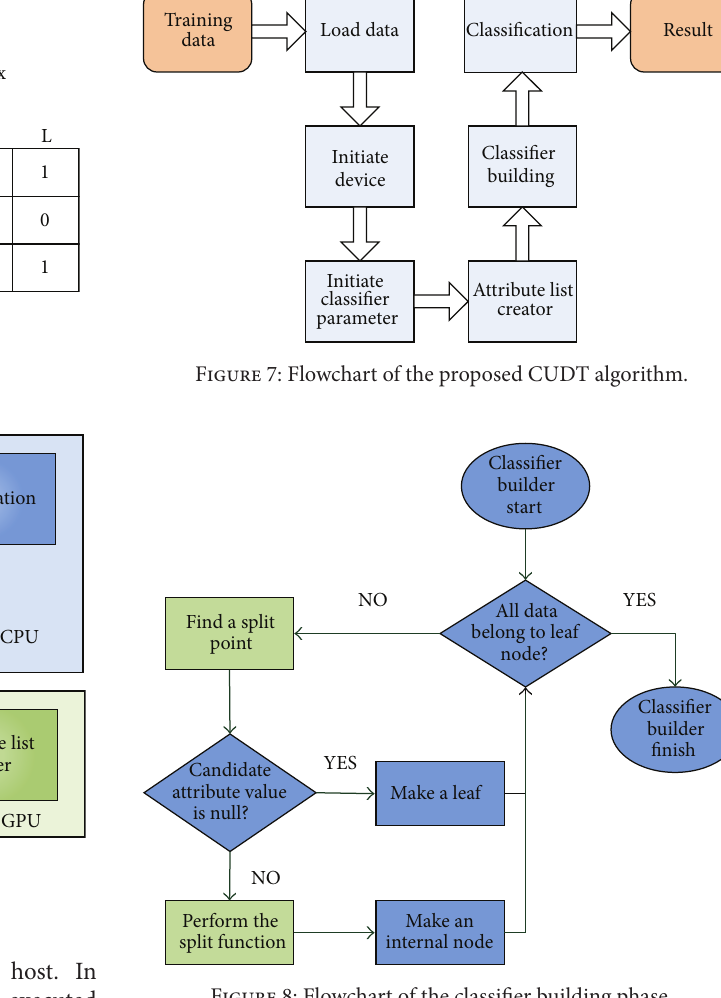
Figure 8: Flowchart of the classifier building